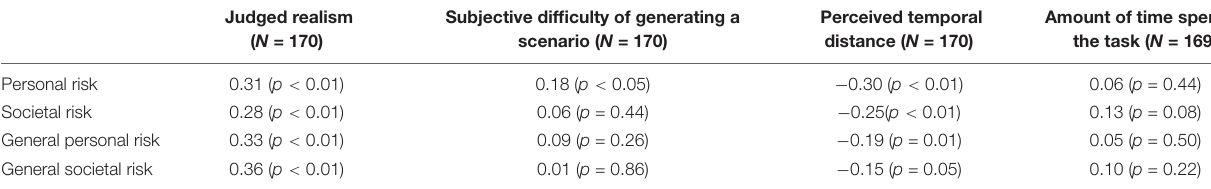
TABLE 2 | Pearson correlations between risk perception and